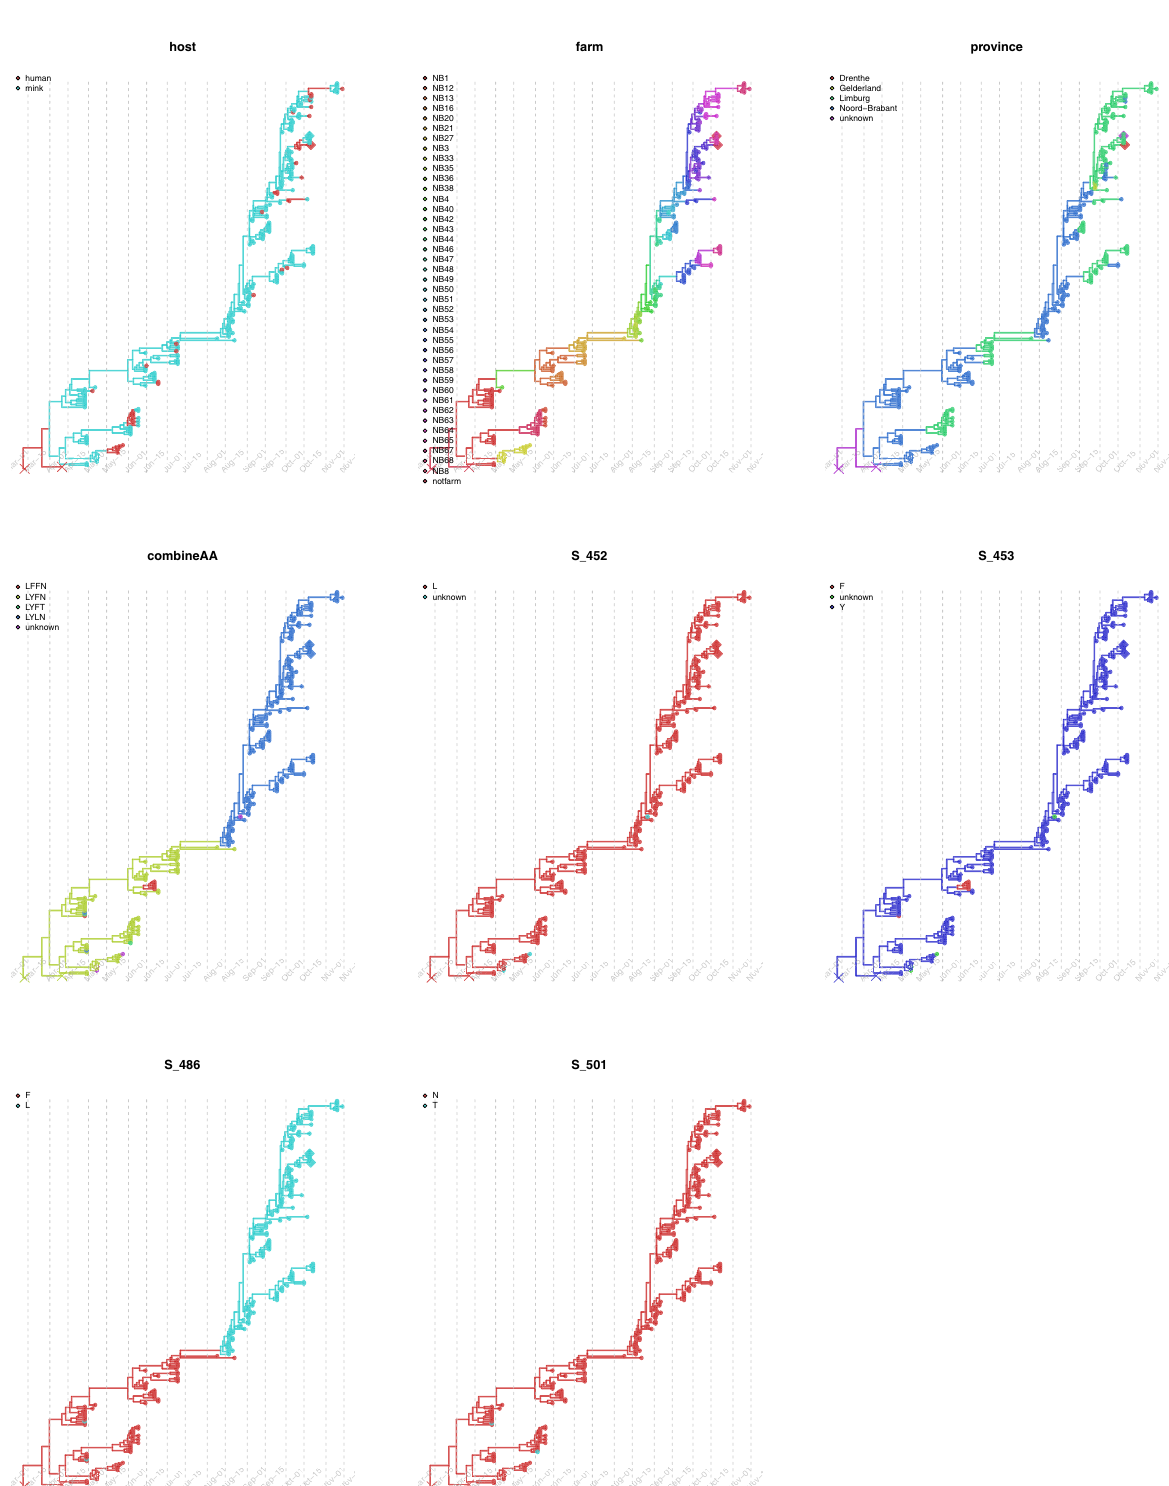
Fig. 3 Discrete trait mapping on time-scaled phylogeny of Cluster A. Eight traits including host, farm ID (farm), province, the 4 unique sites in the spike protein with amino acid changes (L452M, Y453F, F486L and N501T) and the combinations of the 4 sites (combineAA) are mapped on the same MCC tree using the discrete trait model. The traits are plotted individually and for each tree, the branches and nodes are coloured by inferred ancestral traits. Samples which fell within mink clusters but not isolated from farms are highlighted in diamond (1 escaped mink and 1 un-associated human sequences). The outgroup containing human samples are cross